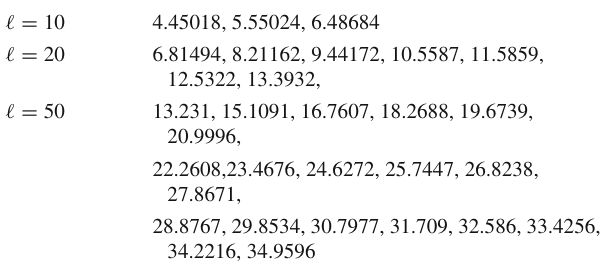
Fig. 7 TheQNMs w = ω r h ( r h = 10 . 6266 ) ofdRGTblackstringwith M = 1 ,α g = 1 ,(cid:14) = 0 ,(cid:15) = − 0 . 01 ,γ = 0 , m = 0 . 2 and (λ, k ) = ( 0 , 0 ),( 1 , 0 ),( 2 , 0 ),( 3 , 0 ),( 5 , 0 ),( 7 , 0 ),( 20 , 1 ),( 20 , 100 ),( 20 , 200 ) (presented by colored dots from the vertical axis out to both sides). In addition to the lowest modes, the next-to-lowest modes appear for sufficiently high momentum (λ, k ) in a repeated pattern at exactly the same values of Re w Table 7 The normal-mode frequencies w = ω r h ( r h = 3 . 122 ) of dRGT black string with M = 1 ,α g = 1 ,(cid:14) = 0 ,(cid:15) = − 0 . 01 ,γ = 0 . 4 , m = 0. The momentum parameter (cid:20) is defined as (cid:20) 2 ≡ λ 2 + k 2 /α 2 g